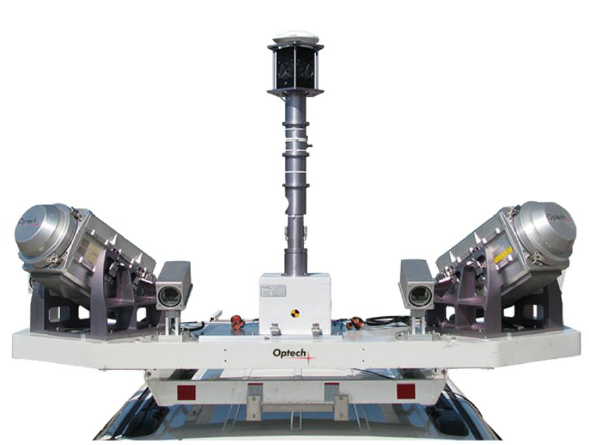
Figure2. Mobile laser scanner (Lynx)